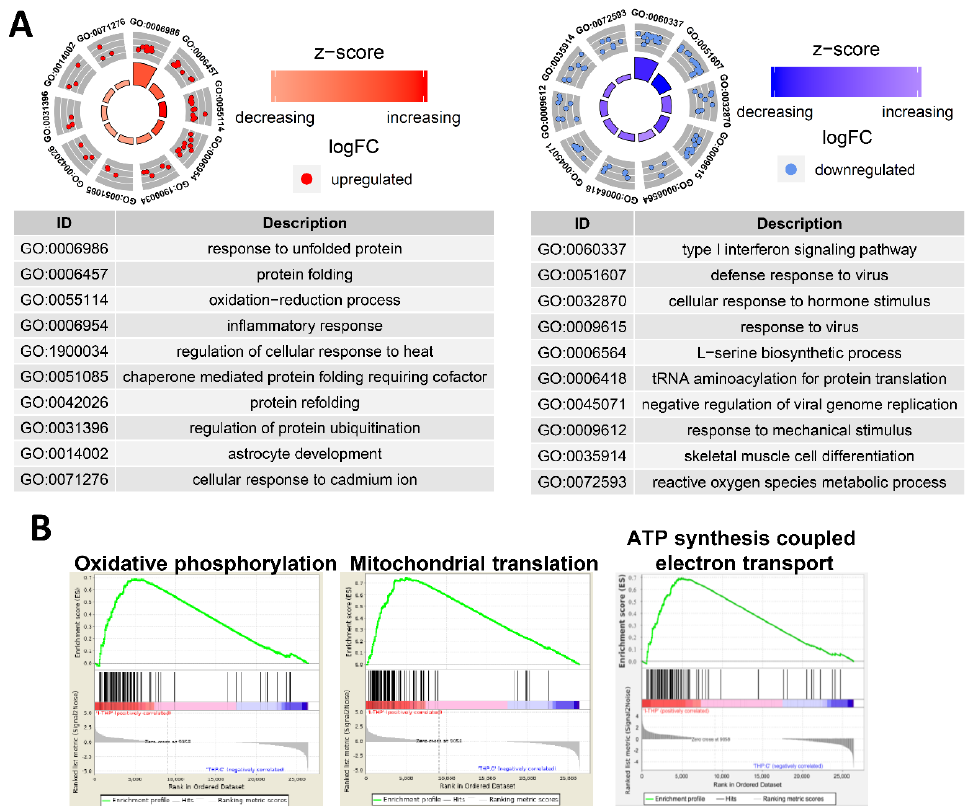
Figure 13. PtNPs alter genes involved in ER and mitochondrial dysfunctions. ( A ). GO circles analyzed with biological processes in DEGs from DAVID. The left circle displays highlighted GO terms of upregulated genes of PtNP-treated sample, and the right circle displays the terms of downregulated genes. Red dots and blue dots represent upregulated and downregulated genes, respectively. Each GO term is noted with a unique GO number. ( B ). Gene set enrichment analyses (GSEA) in the PtNP-treated sample. GSEAs associated with mitochondria dysfunctions are shown.